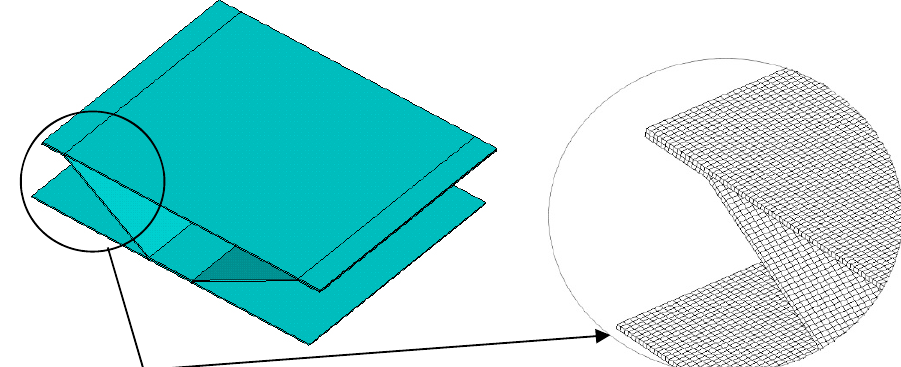
Figure 3: FEM model used to validate the analytical